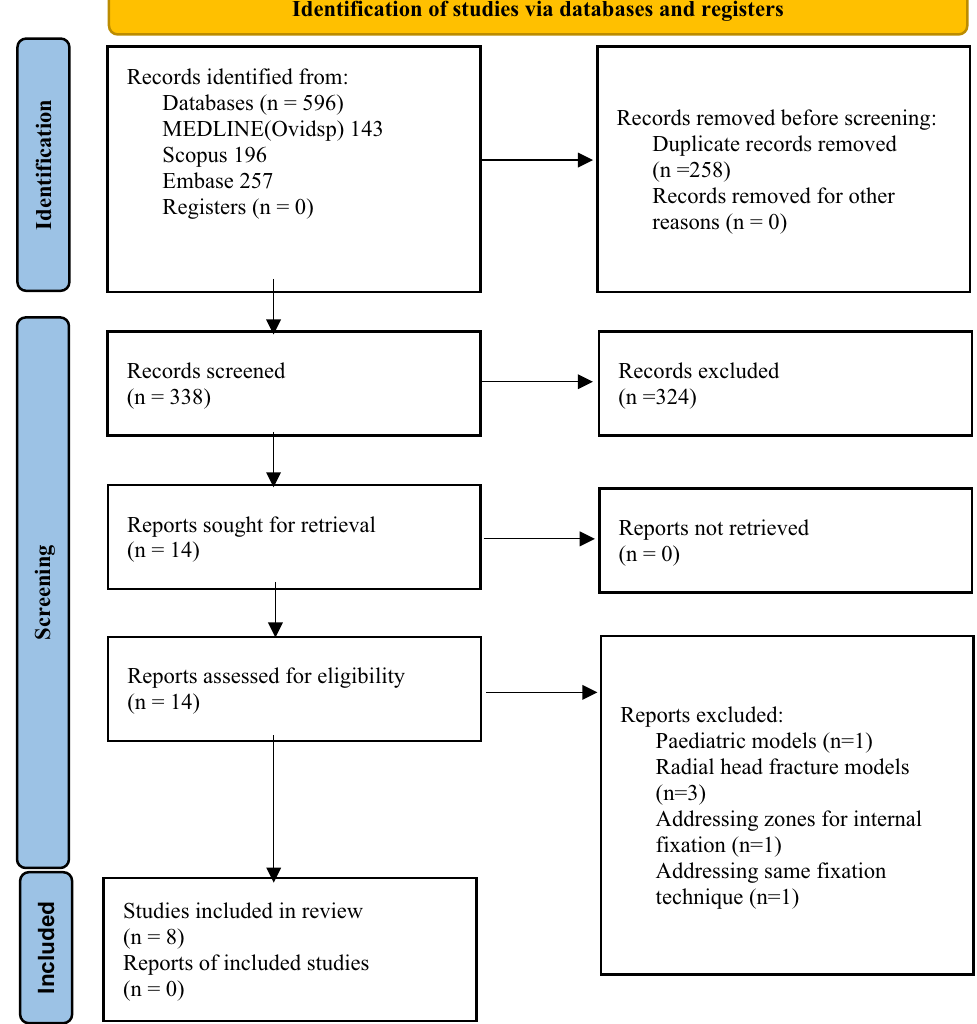
Figure 1. Flowchart of network meta-analysis for biomechanical studies in displaced radial neck